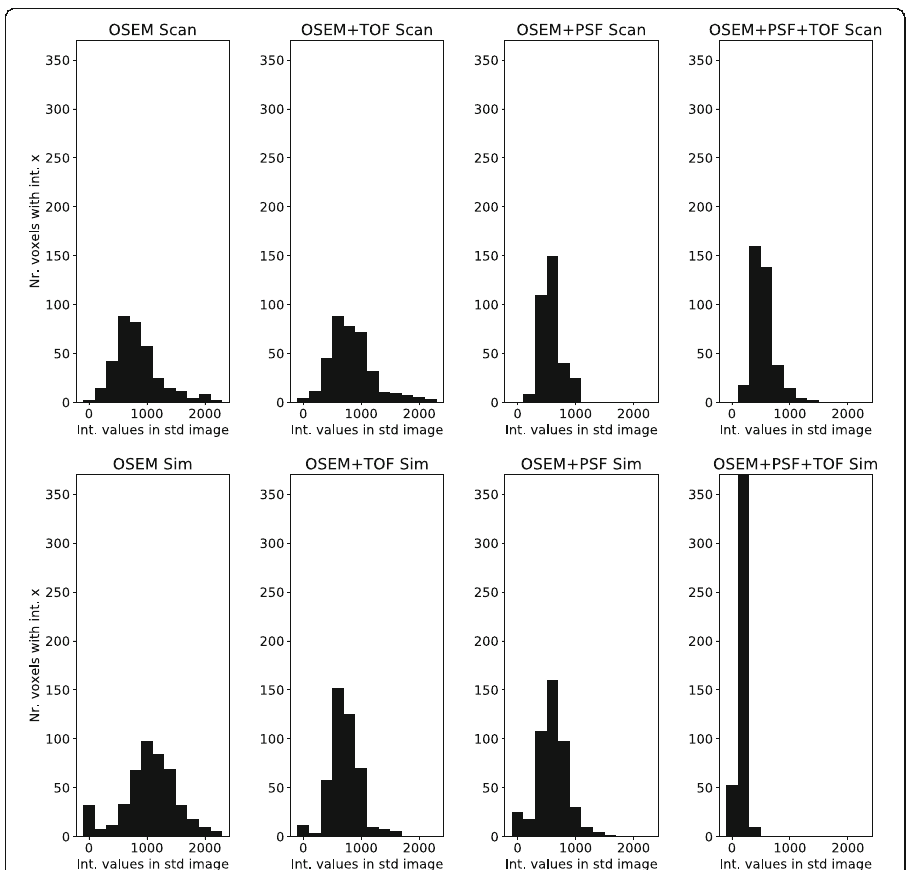
Fig. 7 The changes in the distribution of standard deviation values over the different reconstruction settings for scan (above) and simulation (down). The values are extracted from a region in the phantom background in the standard deviation